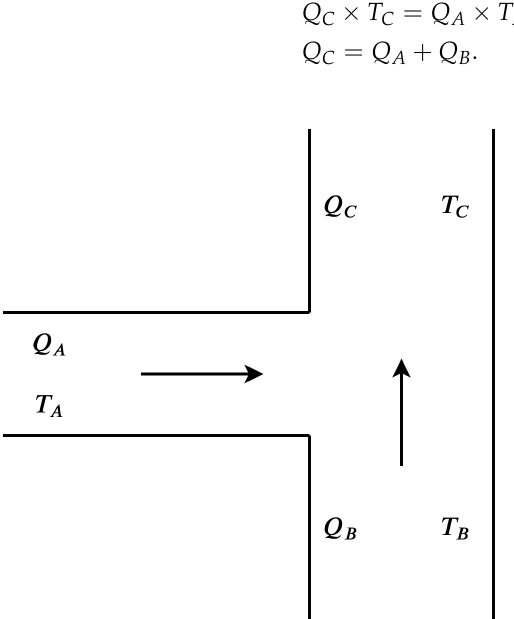
Figure 7. Schematic of alligation alternate